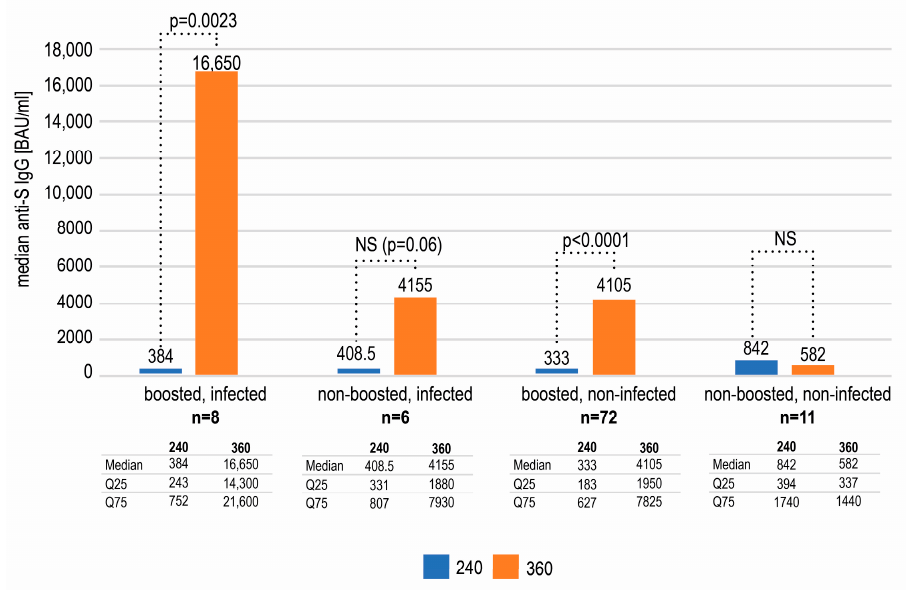
Figure 4. The median antibody concentrations and interquartile ranges on days 240 and 360 in subgroups defined by the recent infection and booster status. A statistically significant rise (Wilcoxon test) between those two timepoints was only seen in the subgroups of boosted subjects.